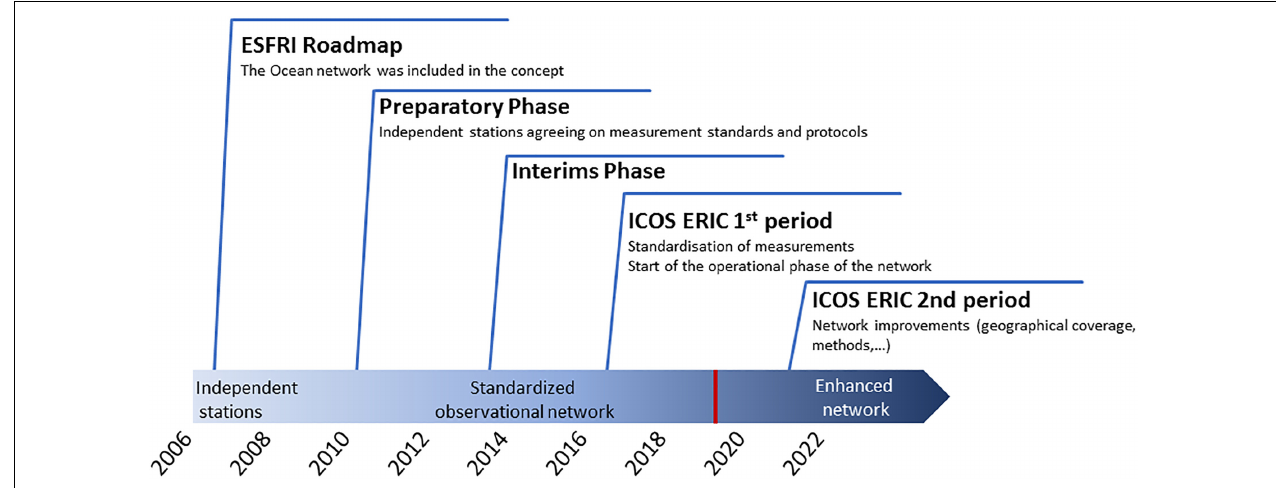
FIGURE 1 | Time line showing the development of ICOS since 2006. The red bar denotes the time of publication of this paper in the development process. It is shown how the stations developed from independent stations to an enhanced network over time (ESFRI: European Strategy Forum on Research Infrastructures; ERIC: European Research Infrastructure